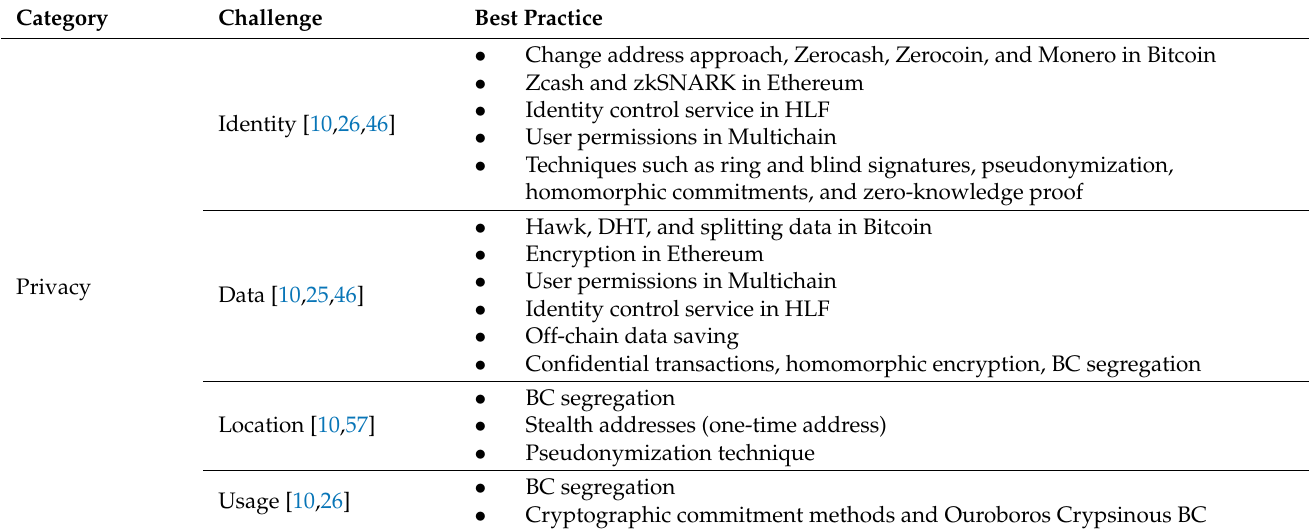
Table 7. Recommendations for reducing the negative impact of privacy